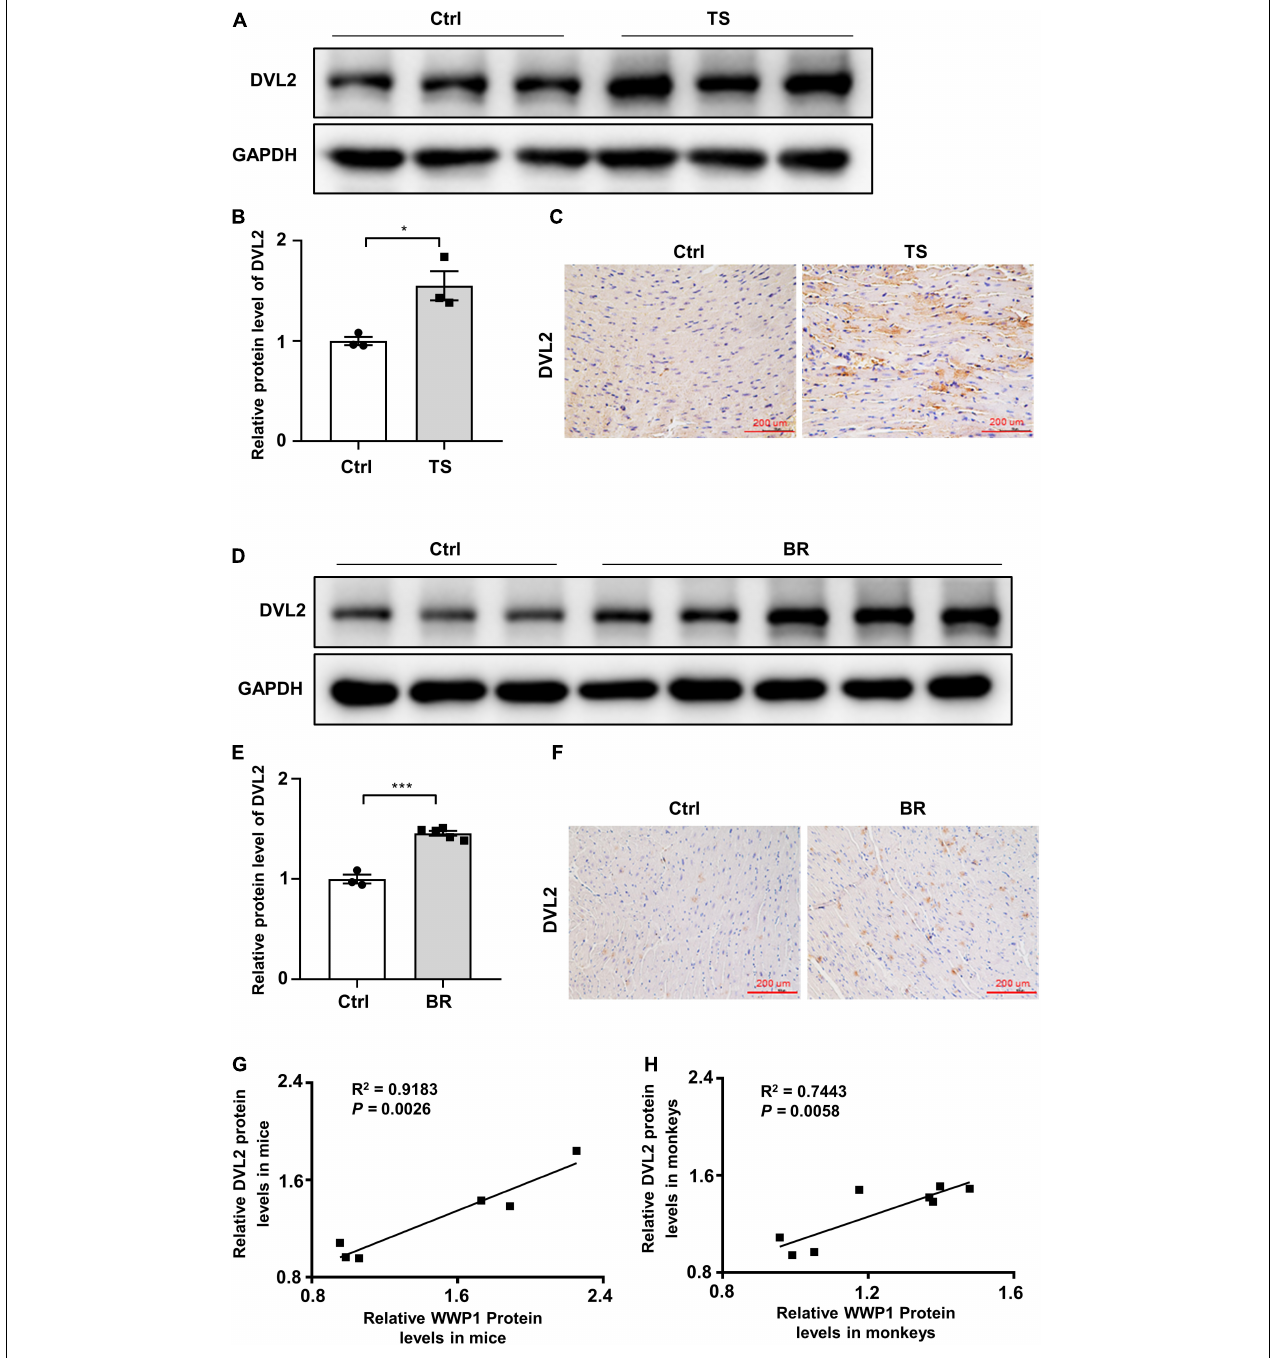
FIGURE 5 | Disheveled segment polarity proteins 2 expression changes in the hearts of mice and rhesus monkeys after simulated microgravity. (A) Representative western blotting analysis of DVL2 expression in cardiac extracts of adult mice following tail suspension (TS) for 6 weeks ( n = 3 for each group). (B) Quantification of DVL2 protein levels of (A) . (C) Immunohistochemistry for DVL2 (brown) in paraffin section from mouse hearts at 6 weeks after tail suspension. Scale bars, 200 µ m. (D) Representative western blotting analysis of DVL2 expression in cardiac extracts of adult rhesus monkeys following bed rest (BR) for 6 weeks (Ctrl, n = 3; BR, n = 5). (E) Quantification of DVL2 protein levels of (D) . (F) Immunohistochemistry for DVL2 (brown) in a paraffin section from rhesus monkey hearts at 6 weeks after bed rest. (G) Pearson correlation coefficients between DVL2 and WWP1 protein levels in the heart of mice following tail suspension. (H) Pearson correlation coefficients between DVL2 and WWP1 protein levels in the heart of rhesus monkeys following bed rest. Scale bars, 200 µ m. Data represent the means ± SEM. * P < 0.05, *** P < 0.001. DVL2, disheveled segment polarity protein 2; TS, tail suspension; BR, bed rest.